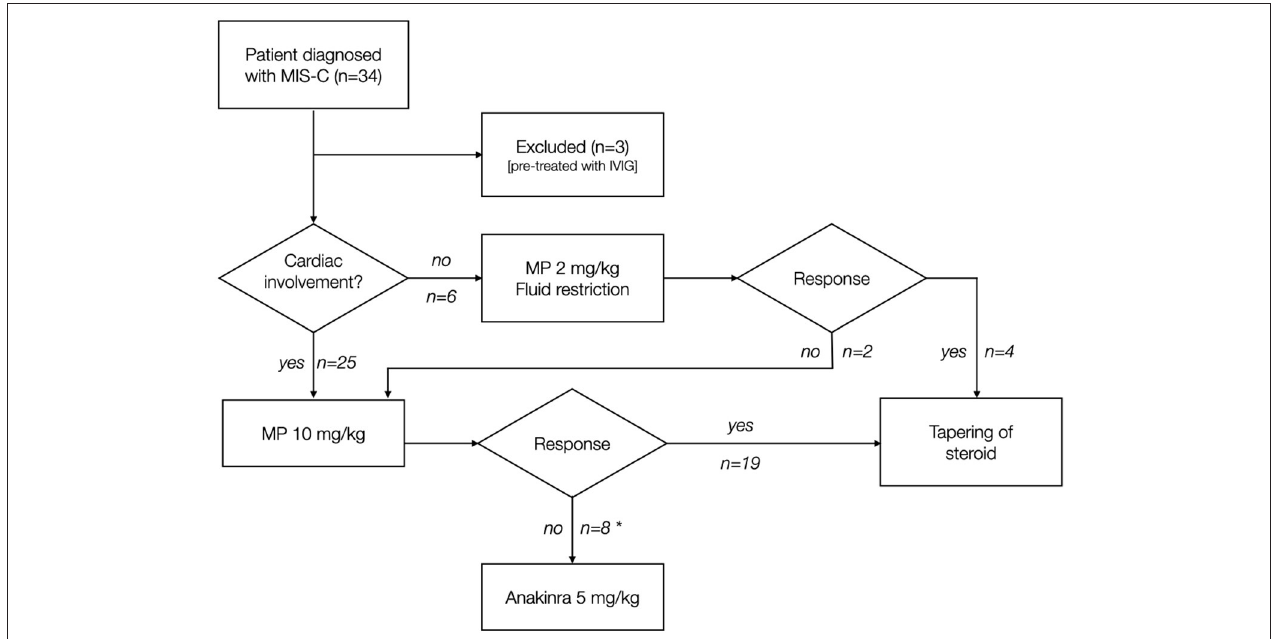
FIGURE 1 | Treatment strategy of patients included in the study. MP was used in patients as first-tier monotherapy. Clinical response was defined as defervescence and CRP reduction after 48h from the first MP dose. *4 patients received